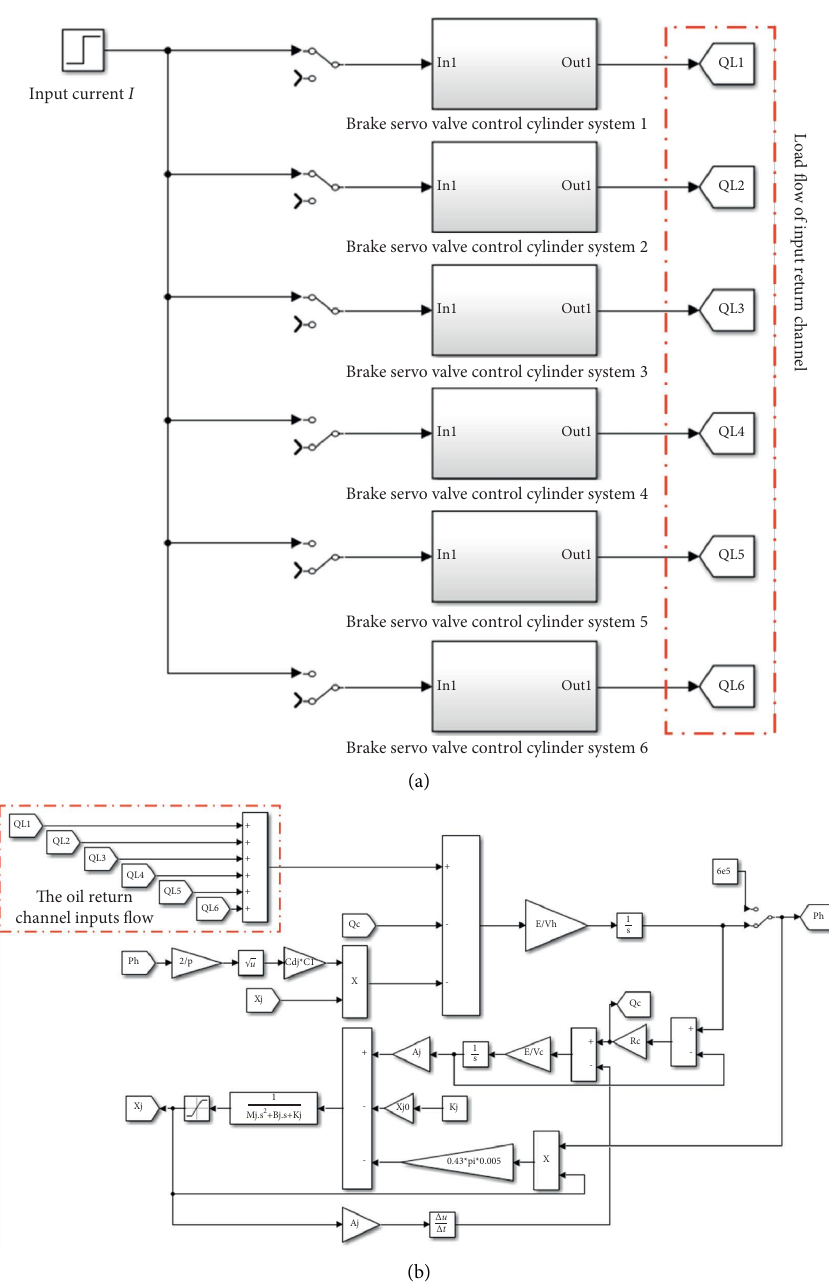
Figure 13: MATLAB/Simulink model of the 6-valve parallel brake control system. (a) Six sets of brake servo valve-controlled cylinder parallel system. (b) Oil return channel